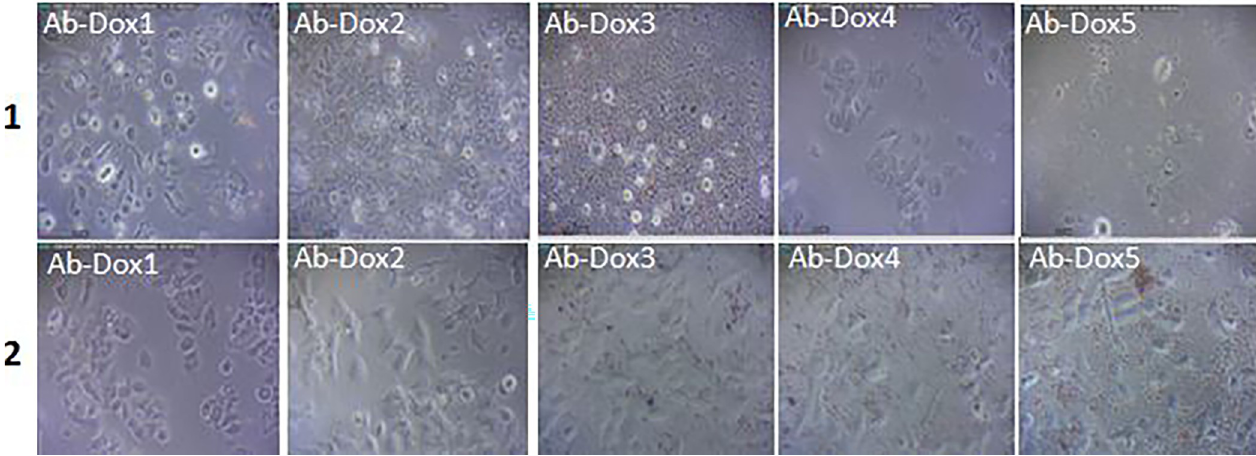
Fig 8. The effects of different concentrations (1, 2, 3, 4 and 5 μ g) of the antibody conjugated to doxorubicin (Ab-Dox) on morphology and the availability of the MCF7 (row 1) and HUVEC cell lines (row 2).